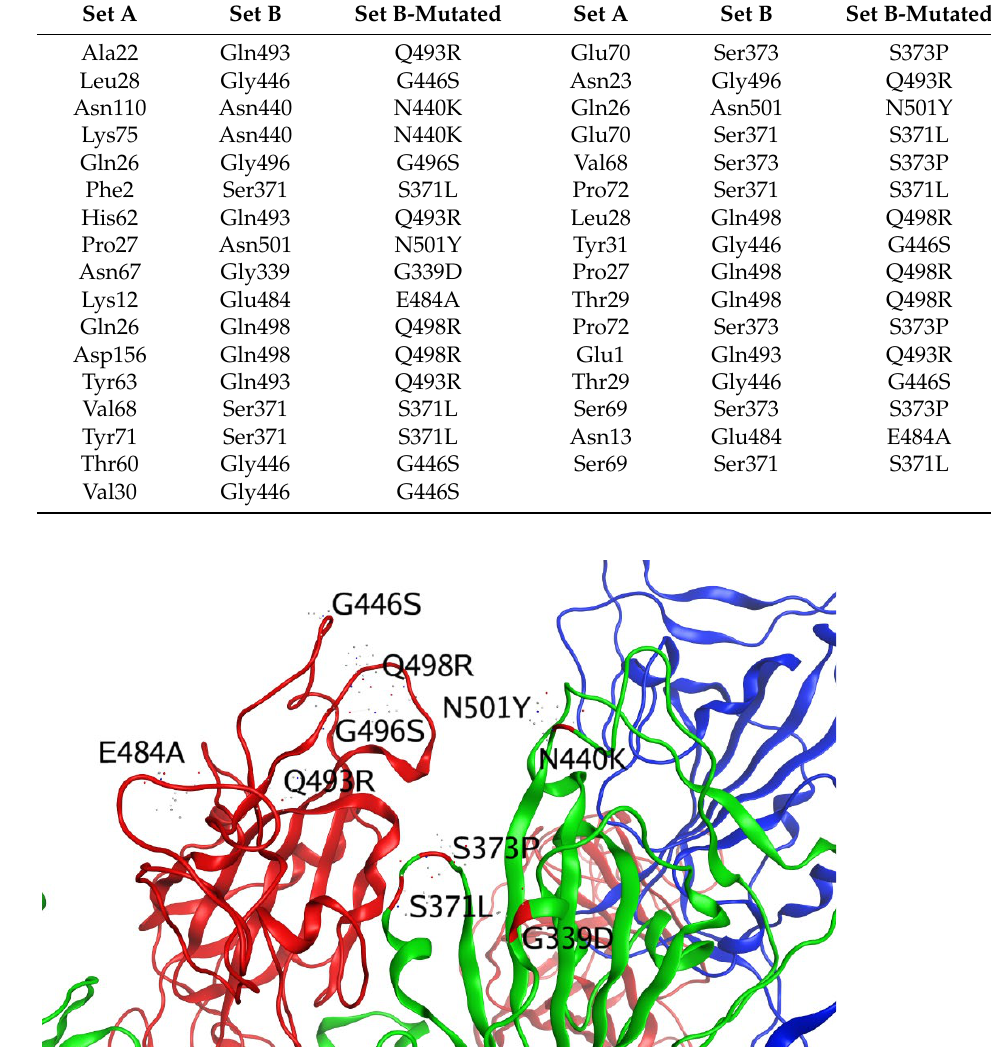
Table 4. Interacting residues involved in the bond between the α7nAChr and the main SARS-CoV-2 spike protein that are mutated in the Omicron variant. Set A refers to the α7nAChr, set B refers to the original spike protein and set B-mutated refers to the mutated residues in the Omicron variant. Set A Set B Set B-Mutated Set A Set B Set B-Mutated Ala22 Gln493 Ser373 Ala22 Leu28